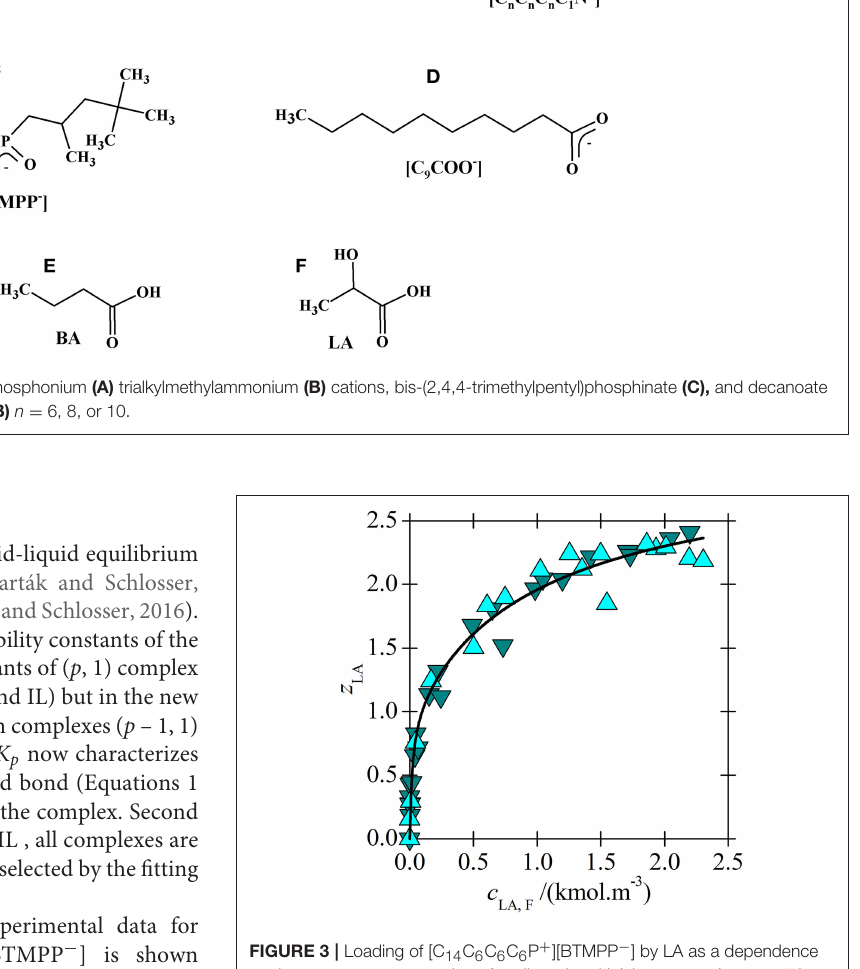
FIGURE 3 | Loading of [C 14 C 6 C 6 C 6 P + ][BTMPP − ] by LA as a dependence on the aqueous concentration of undissociated LA in systems (water + 70